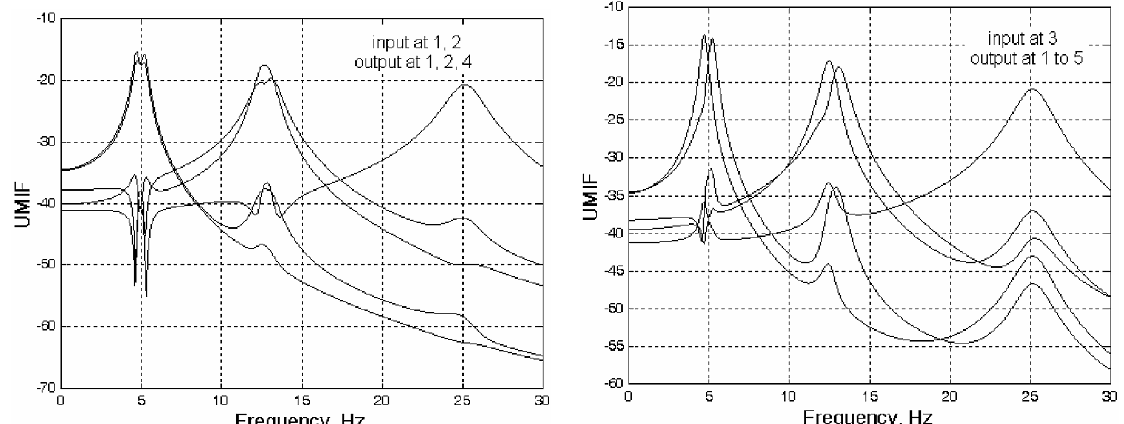
Fig. 8. UMIF for the 5-dof system. Fig. 9. UMIF for the 5-dof system.